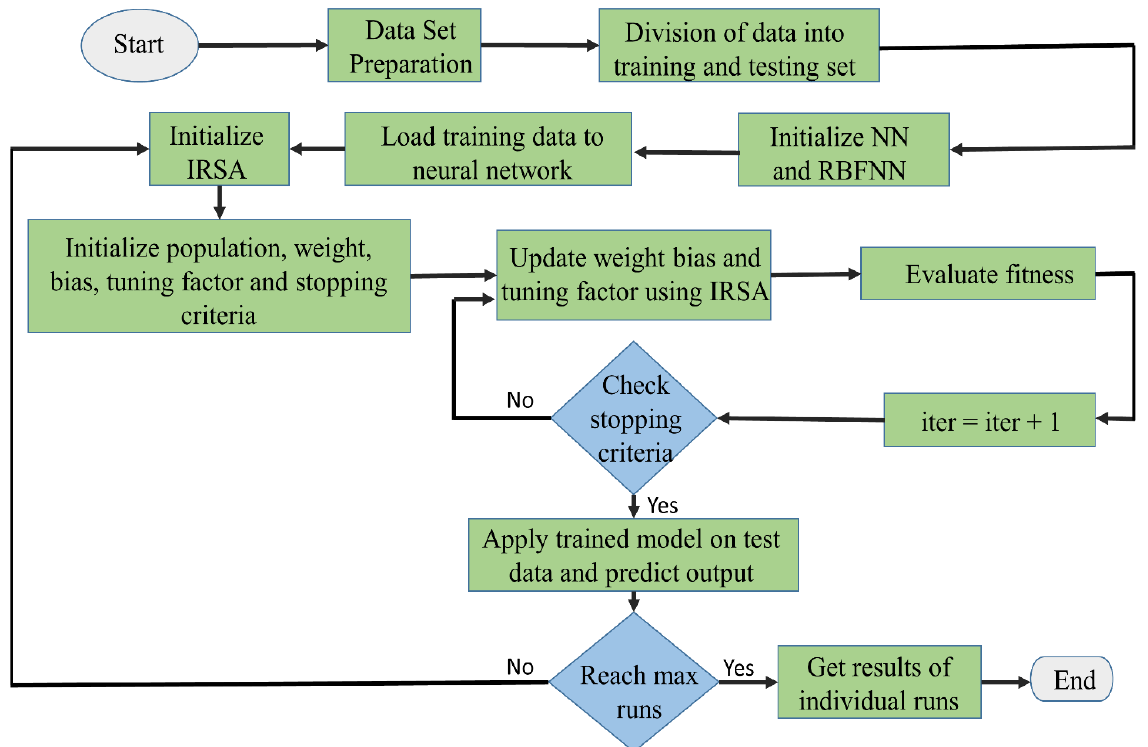
Figure 7. Flow chart of IRSANN algorithm.